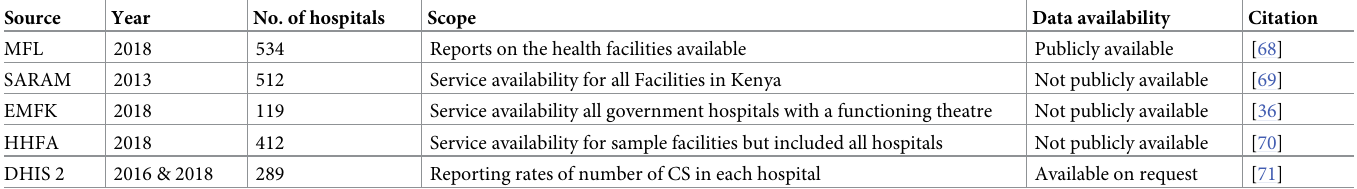
Table 1. Summary of sources of hospital data, the years they represent, their scope and availability status.